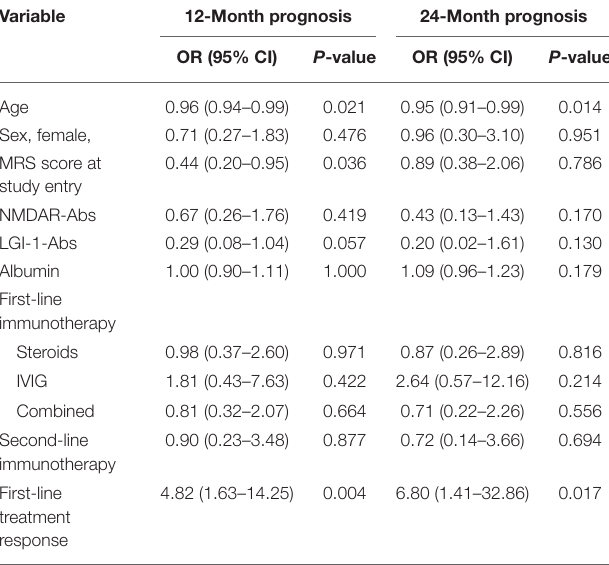
TABLE 5 | Multivariate analysis of factors associated with poor prognosis in patients with